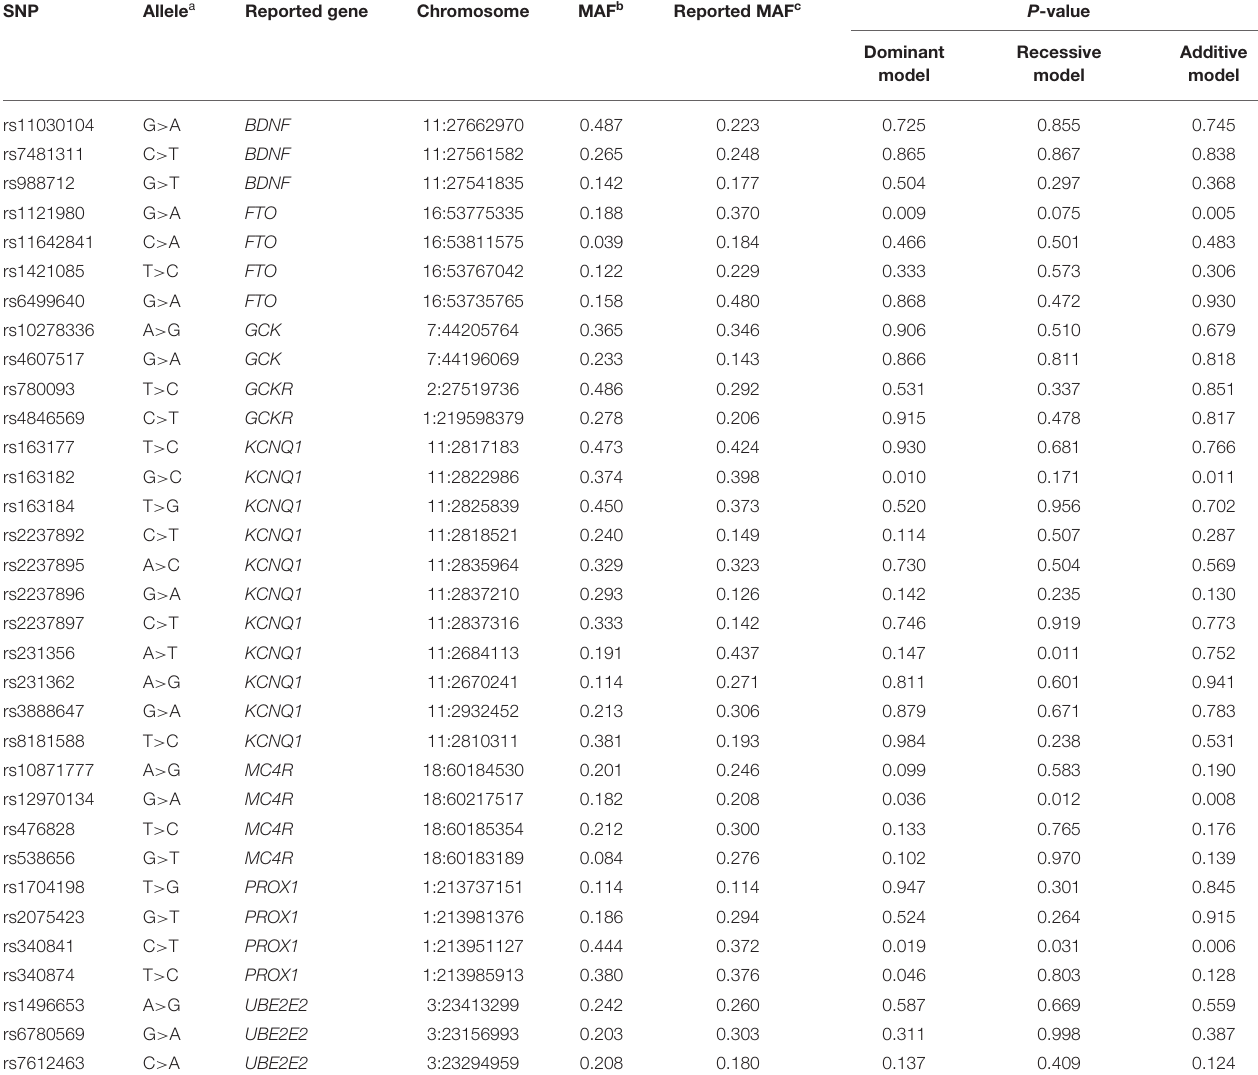
TABLE 2 | Genotyping results in gestational diabetes cases and